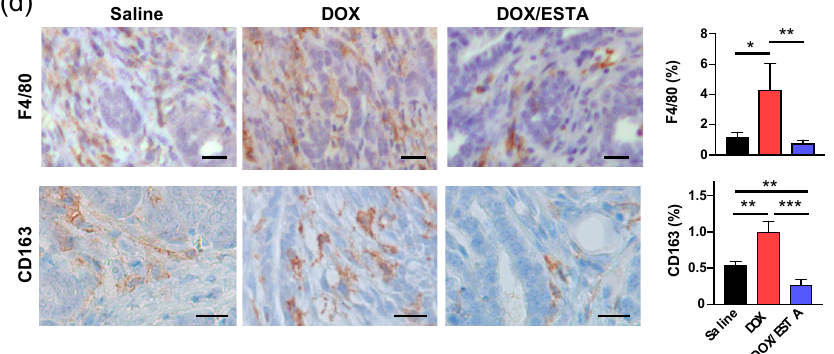
Figure 4. Suppression of immune cell infiltration by ESTA in DOX-treated tumors. ( a ) FACS analysis of TILs in tumors derived from py8119 cells. The data were depicted as mean ± SE and analyzed by the Student’s T -test. ( b ) Analysis of TIL subsets. A pool of tumors ( n = 6) analyzed by FACS for T H 1 and T H 2, following activation. ( c ) FACS analysis of TAMs in breast tumors of MMTV-pyMT mice. The data are depicted as mean ± SE and analyzed by the Student’s T-test. * p < 0.05; ** p < 0.01. ( d ) Immunohistochemistry of TAMs. Representative images show overall TAMs (F4 / 80) and M2 TAMs (CD163) in brown and the nucleus in blue. Graphs summarize TAMs and M2 TAMs in stromal area (cells / stromal area mm 2 ) at a final magnification of × 200. Scale bar indicates 20 µ m. The cells were counted from three representative images of six individual tumors. Statistical significance was analyzed by the Student’s T-test. * p < 0.05; ** p < 0.01; *** p <